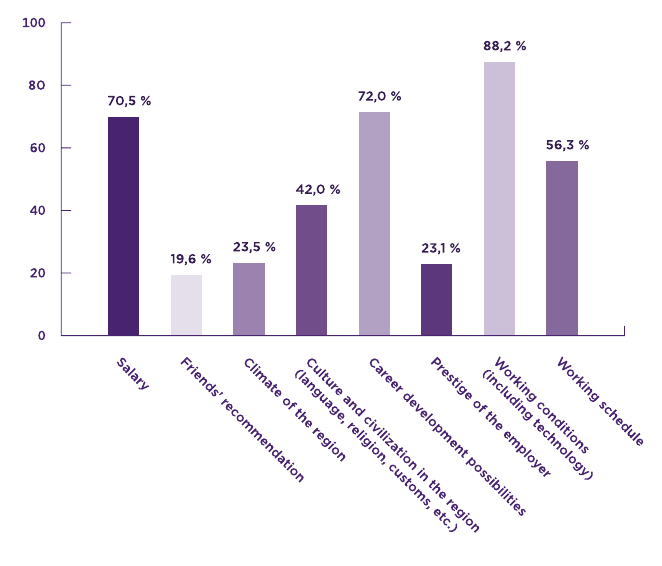
Fig. 4 Main criteria when choosing a new